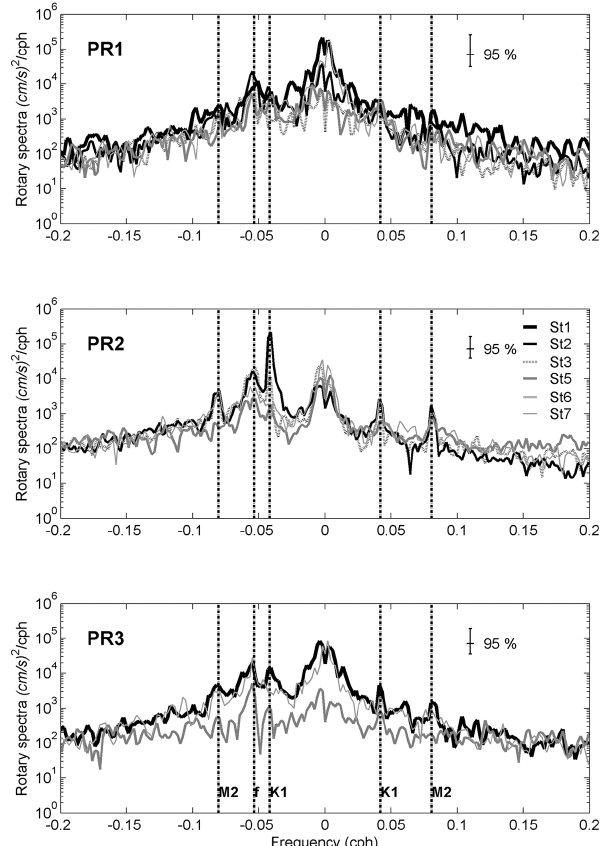
Fig. 4. Rotary spectral analysis in the upper layer along the Otranto section for the three time intervals PR1, PR2, and PR3 from the OTRANTO/OGEX project. The 95% confidence level is indicated. f is the Coriolis parameter divided by 2 π